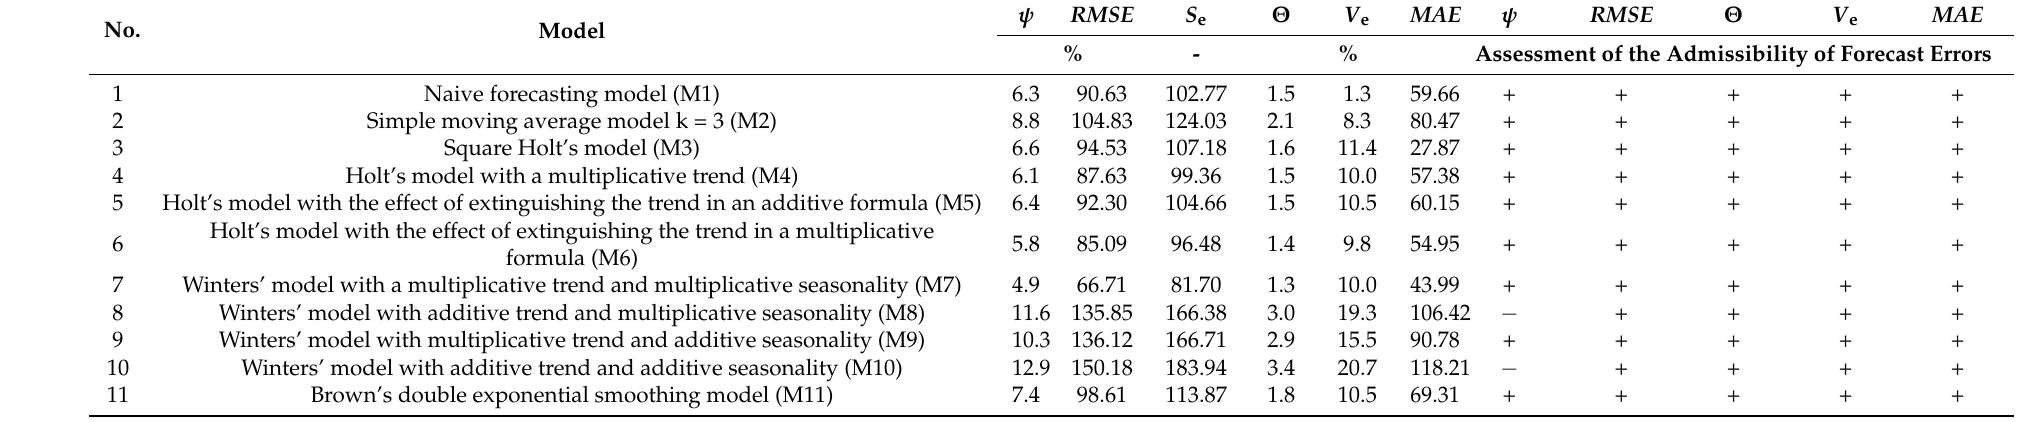
Table 5. Estimated values of errors in ex post forecasts for realized analysis (own study) (plus—the forecast is considered acceptable; minus—the forecast was found unacceptable). No.